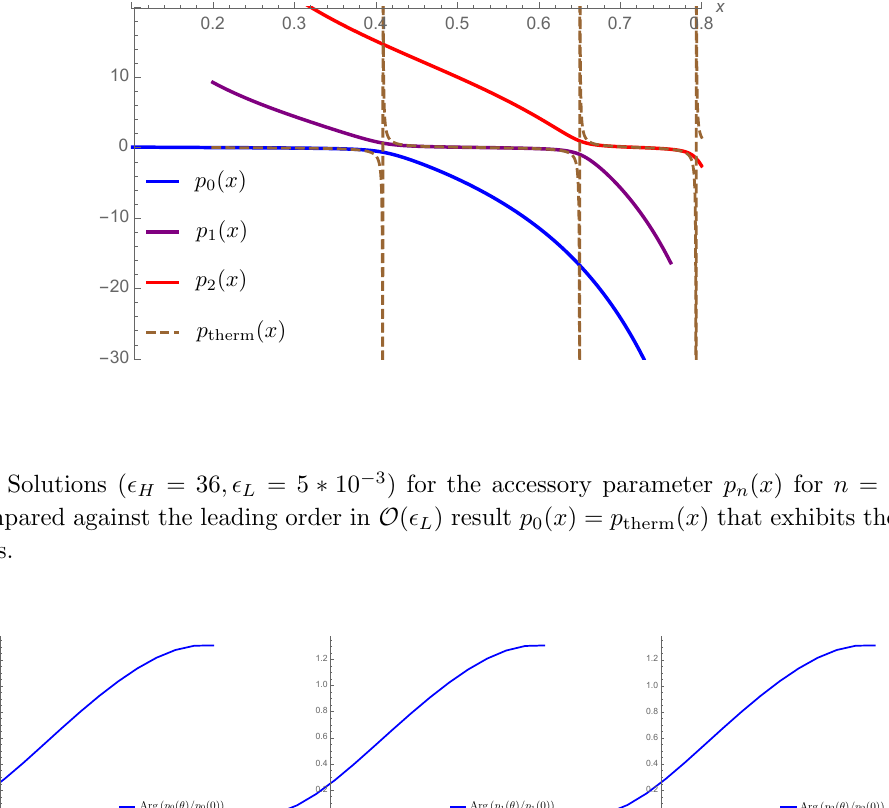
n 1 ( x ) around the branch point above the forbidden (cid:0) = x n + i 4 (cid:15) L for n = 1 ; 2 ; n p n (cid:0) 1 ( x n ) j j